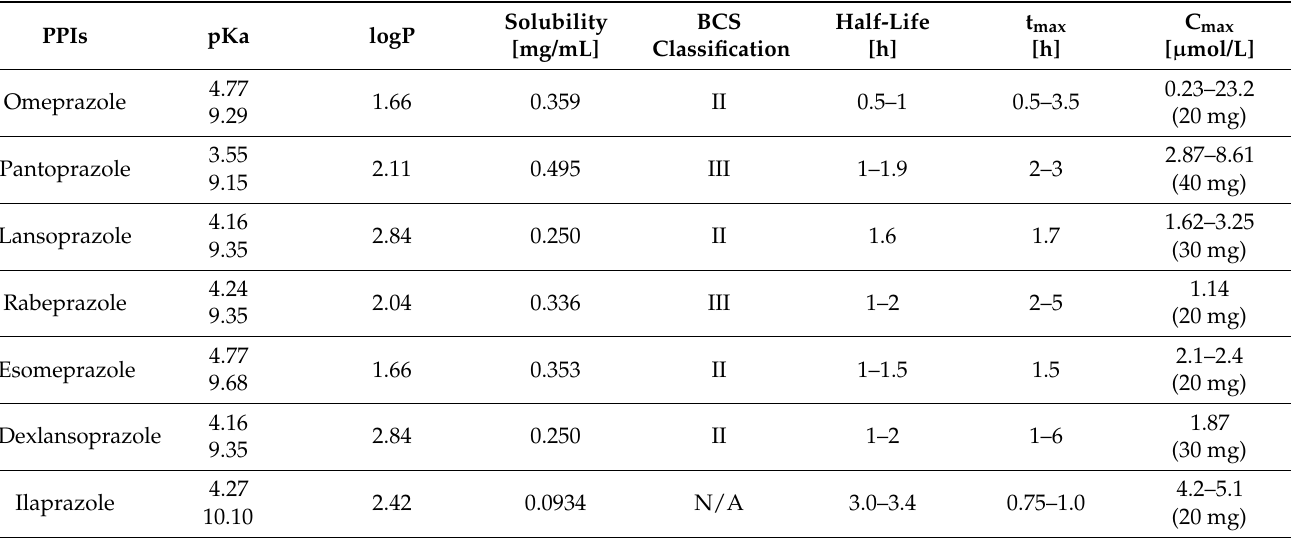
Table 1. Pharmacological characteristics and medical uses of Proton Pump Inhibitors (according to a DrugBank